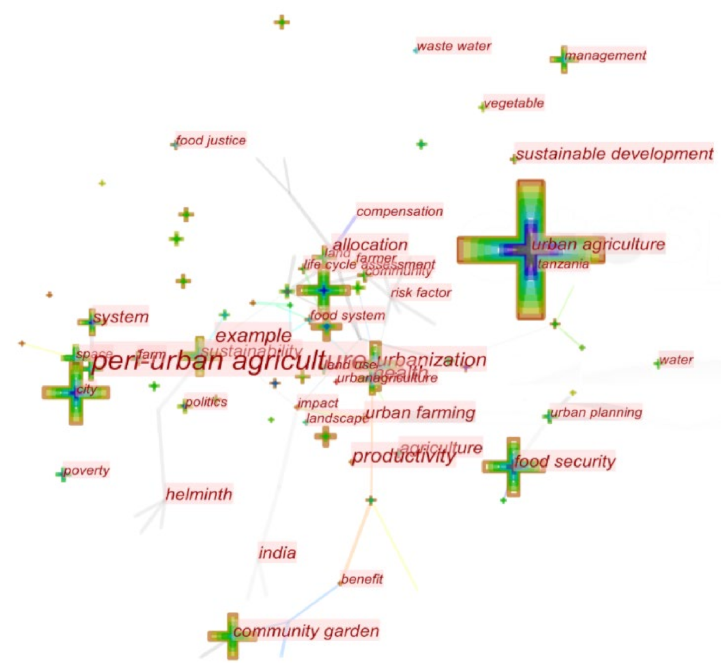
Figure 5. Network of keywords in the field of urban agriculture from 2001 to 2021.